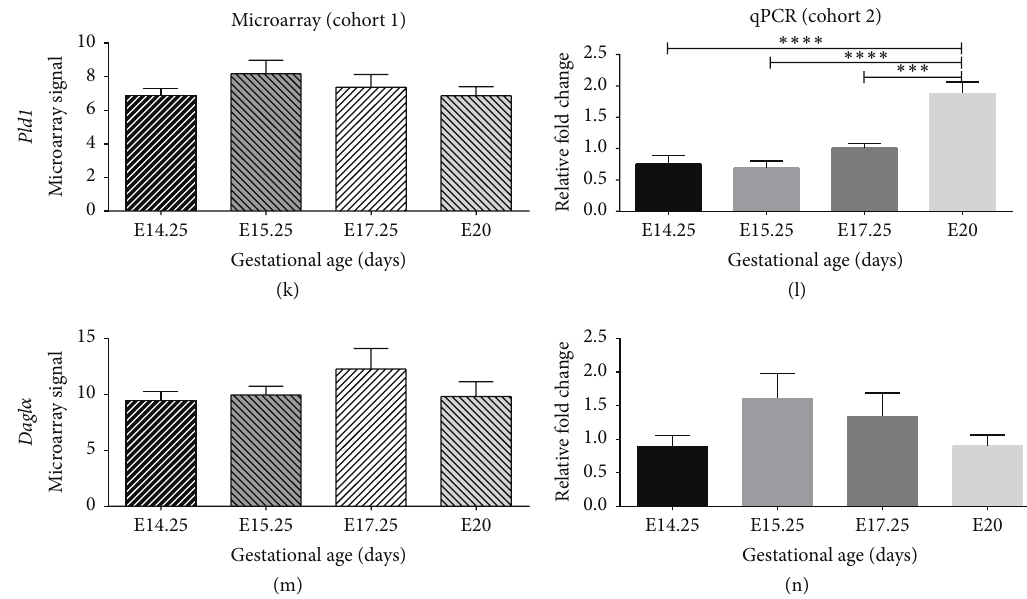
Figure 3: Differential expression of seven eicosanoid enzyme genes assessed by microarray (cohort 1) and validated by qPCR (cohort 2). The left panel shows the results of the microarray analyses; the right panel displays the results of the qPCR. (a) Ptgs2 by microarray in cohort 1 has been previously published. The level of statistical significance is shown as asterisk. Gene expression changes were considered significant when gene expression was changed by > 2 ( ∗ 𝑃 < 0.05 ; ∗∗ 𝑃 < 0.005 ; ∗∗∗ 𝑃 < 0.001 ; ∗∗∗∗ 𝑃 < 0.0001 ; and ns 𝑃 > 0.05 ).